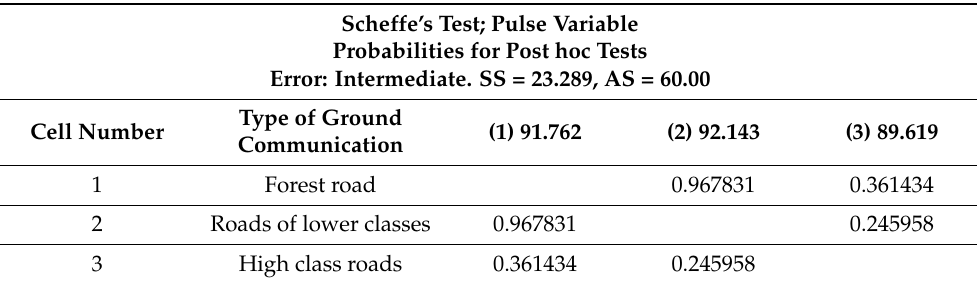
Table 6. Post hoc test to analyze the variance of heart rate values depending on the type of communi- cation when driving the timber truck with